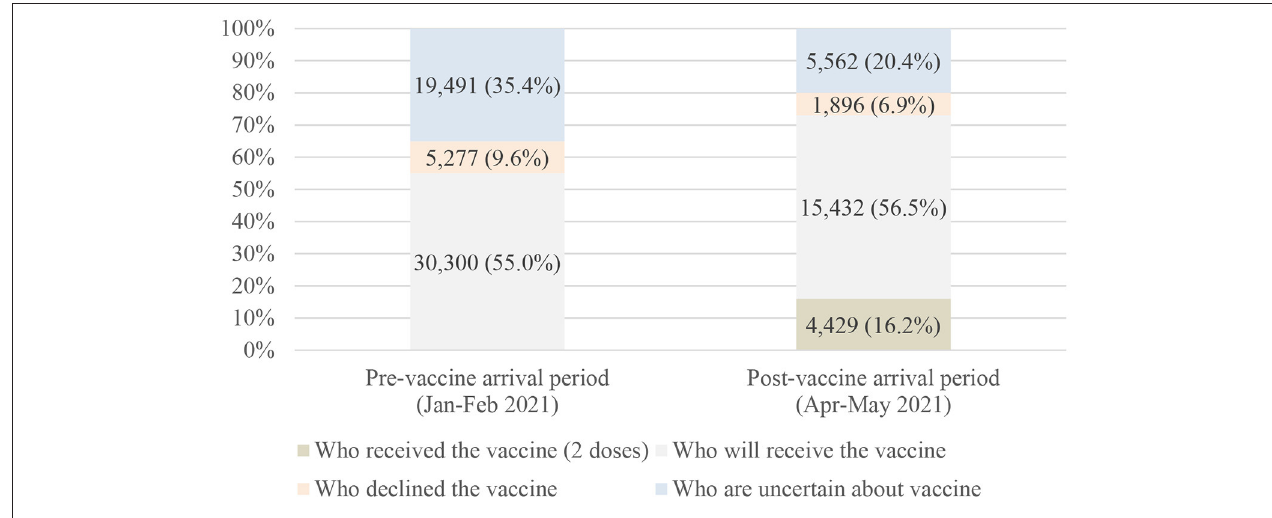
FIGURE 1 | Vaccine hesitancy before and after vaccine availability ( N =